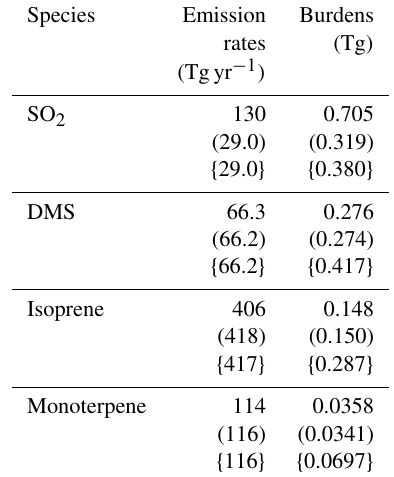
Table 1. Overview of global emission rates and burdens of the pre- cursor gases in CAM5.3-Oslo. The values come from three different simulations using aerosols and oxidants from present day, aerosols from preindustrial and oxidants from present day (in round brack- ets) and aerosols and oxidants from preindustrial (in curly